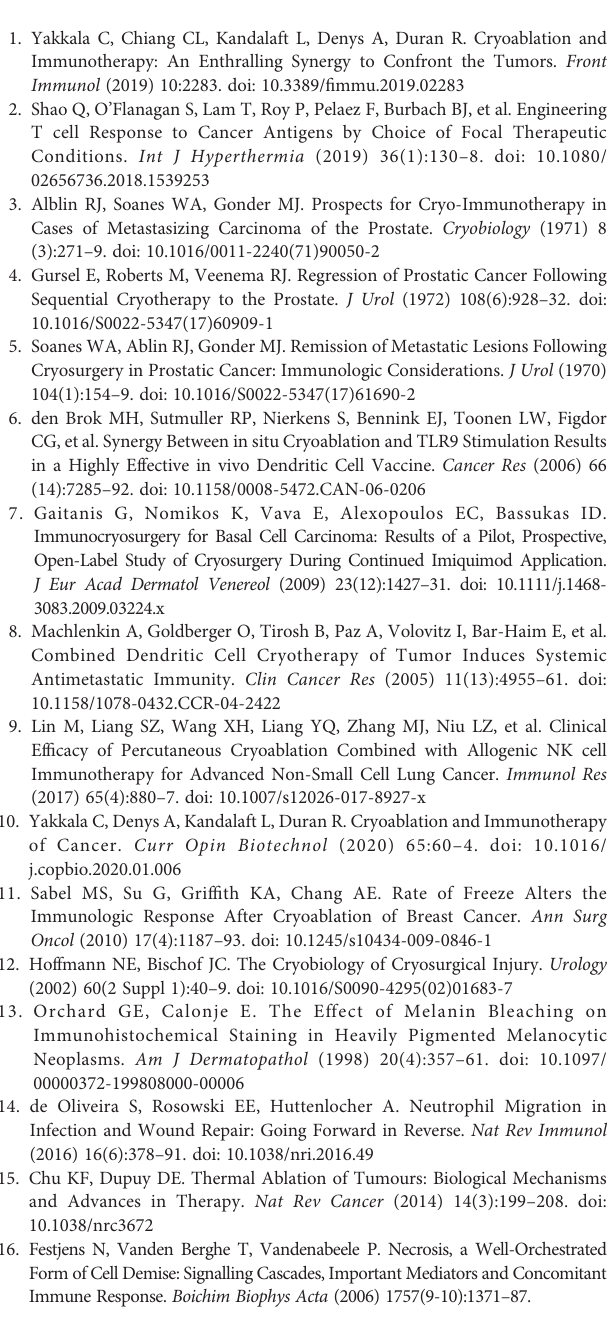
Supplementary Table 5 | Differences in percentages of immune cell populations between experimental groups at day 3-4 post cryoablation in tumors. Data was analyzed using non-parametric Mann-Whitney U test. NS, not signi fi cant. Higher ( ↑ ) or lower ( ↓ ) post cryoablation than non-treated controls (columns 1 and 2). Higher ( ↑ ) or lower ( ↓ ) post fast freeze than slow freeze group (column 3).